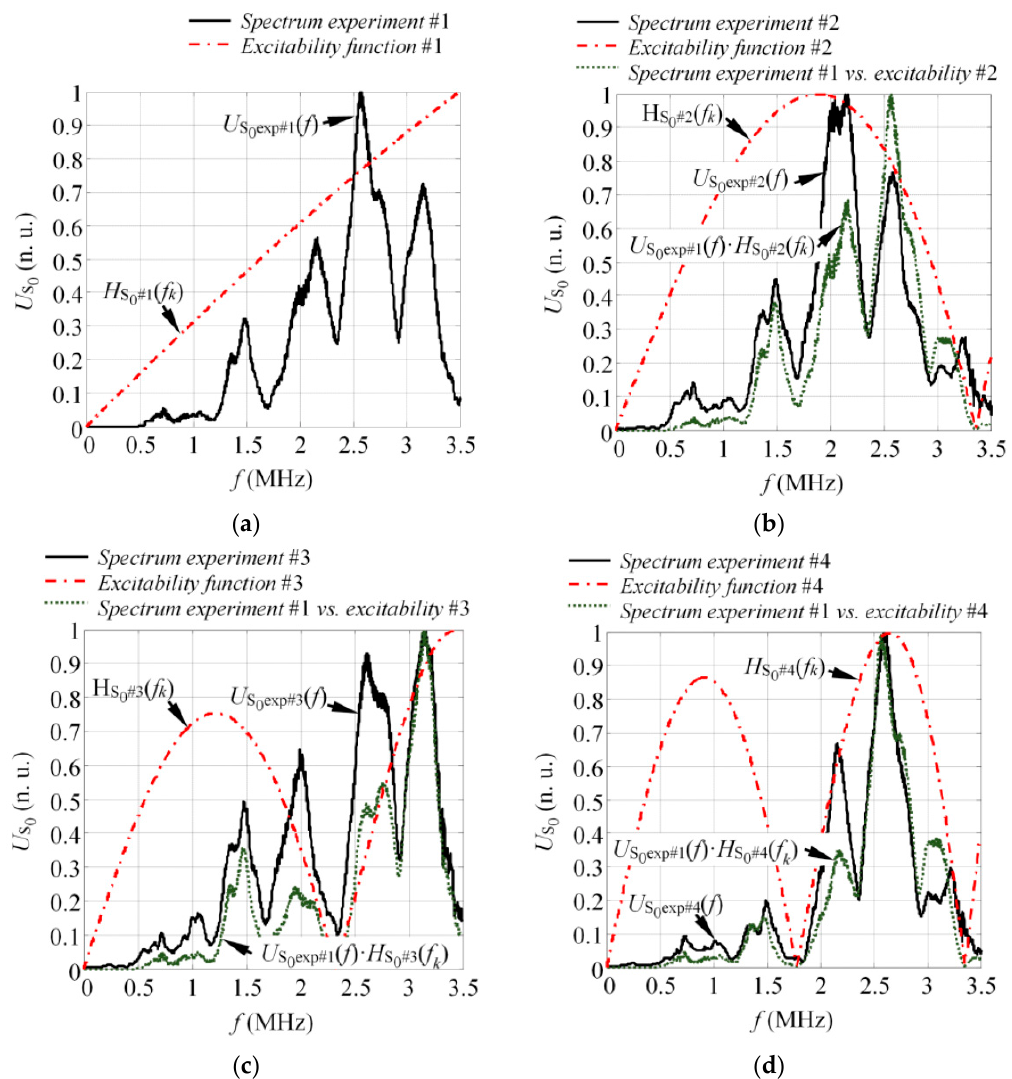
Figure 15. The influence of the source size to the frequency spectrum of the S 0 mode on the 0.5 mm aluminum sample when the active aperture was 0.5 mm (Experiment #1) ( a ); 1.25 mm (Experiment #2) ( b ); 2 mm (Experiment #3) ( c ); and 2.75 mm (Experiment #4) ( d ).